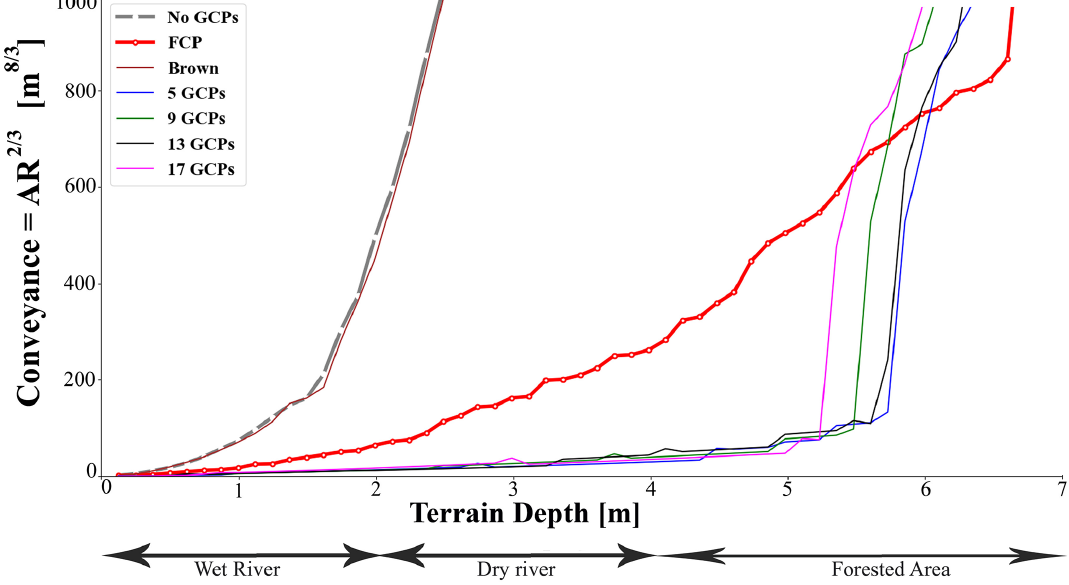
Figure 16. Cross section 3 (south of the terrain) for the conveyance vs. depth relationship.